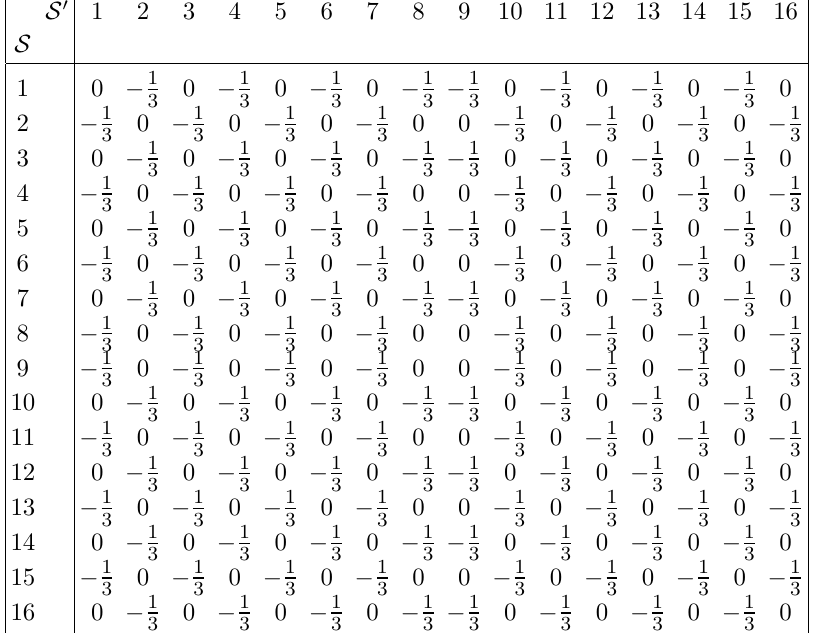
(cid:2) P with di(cid:11)erent boolean factors. [1] [3]